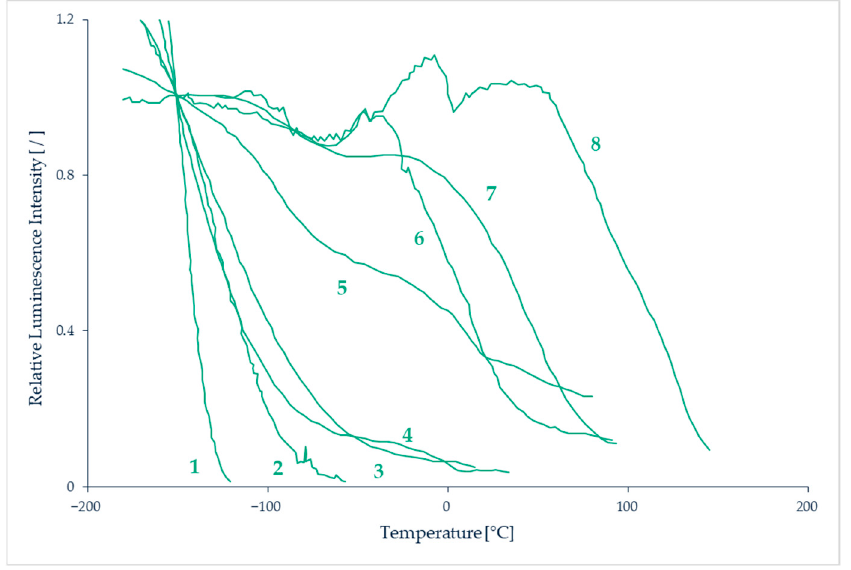
Figure 14. Sensitivity of several TSPs to temperature. Data from Liu et al. [92]. Luminescence intensity is plotted as a function of temperature, normalised by the intensity at a reference temperature T ref = − 150 ◦ C. (1) Ru(trpy) in ethanol/methanol, (2) Ru(trpy)(phtryp) in GP-197, (3) Ru(trpy) in DuPont ChromaClear, (4) Ru(VH127) in GP-197, (5) Ru(trpy)/zeolite in GP-197, (6) EuTTA in dope, (7) Ru(bpy) in DuPont ChromaClear, (8) Perylenedicarboximide in sucrose octaacetate.